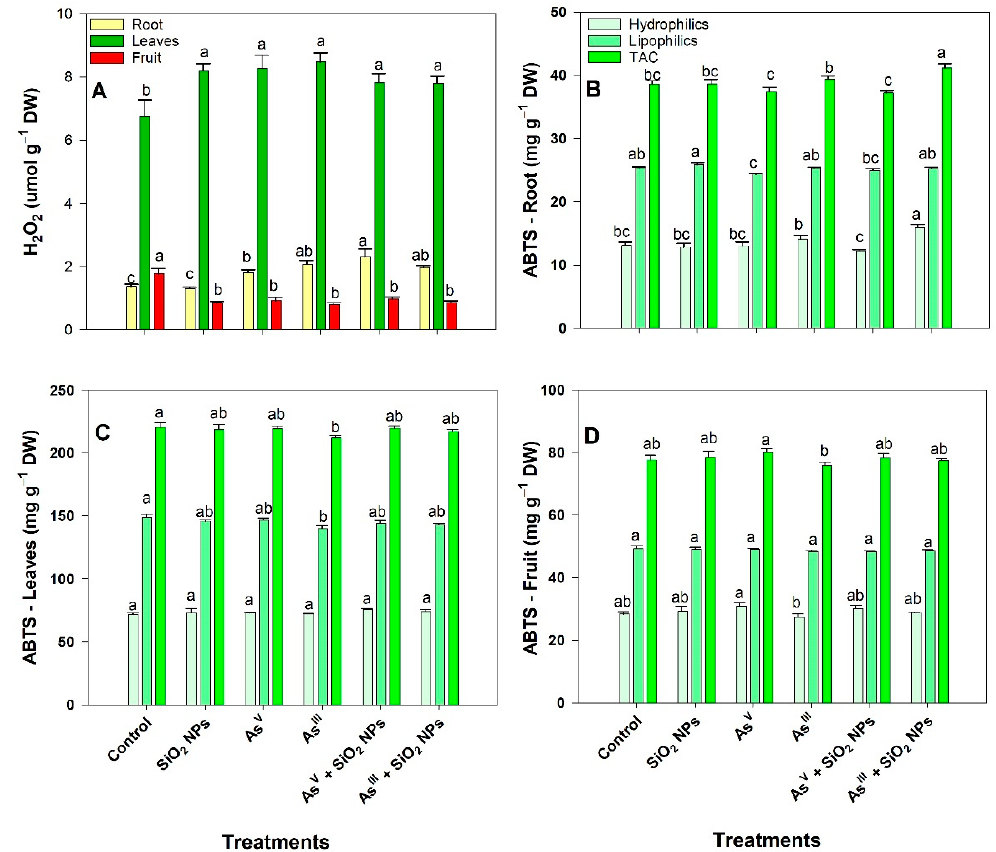
Figure 7. Hydrogen peroxide (H 2 O 2 ) and ABTS antioxidant capacity in roots, leaves, and fruits of tomato plants. ( A ) H 2 O 2 levels, ( B ) antioxidant capacity ABTS in roots, ( C ) antioxidant capacity ABTS in leaves, and ( D ) antioxidant capacity ABTS in fruits. Plants treated with 3.2 mg L − 1 of As V (Na 2 HAsO 4 · 7H 2 O) and As III (NaAsO 2 ) via irrigation through the nutrient solution and 1000 mg L − 1 of SiO 2 NPs via substrate. Lower-case letters different per bar indicate statistical differences according to the Fisher’s least significant difference test ( p ≤ 0.05). n = 5 ± standard